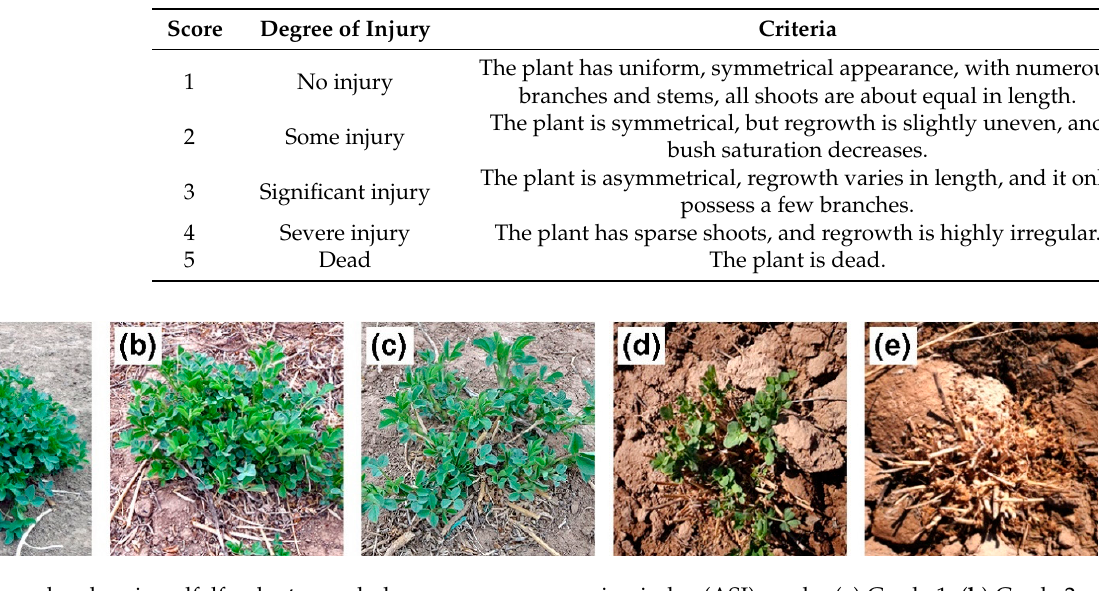
Table 3. Rating criteria for Alfalfa’s wintering performance.